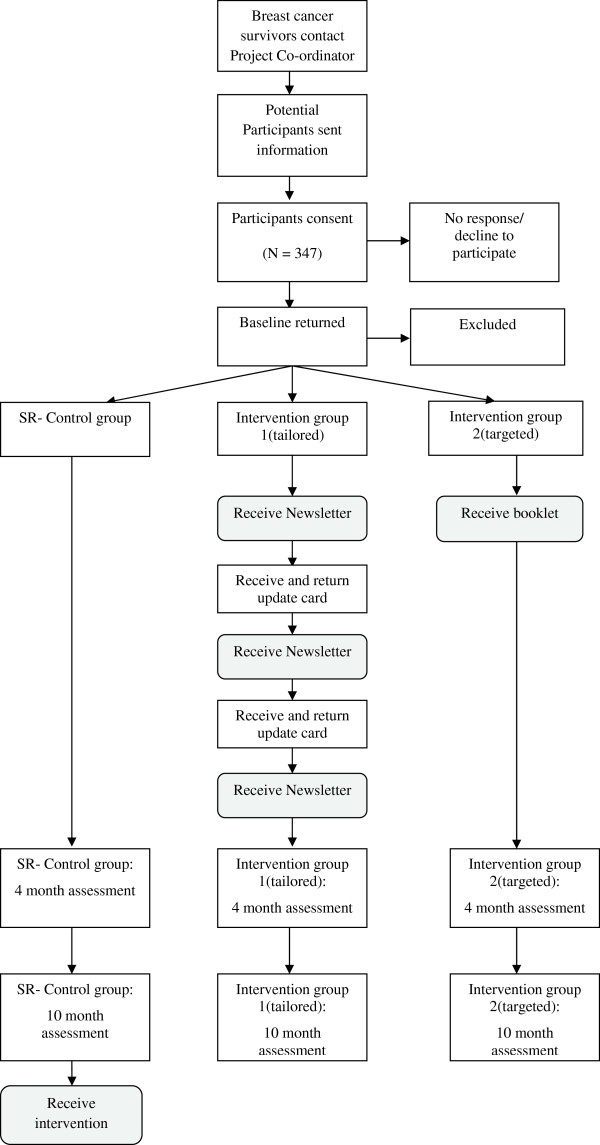
Study flow chart.